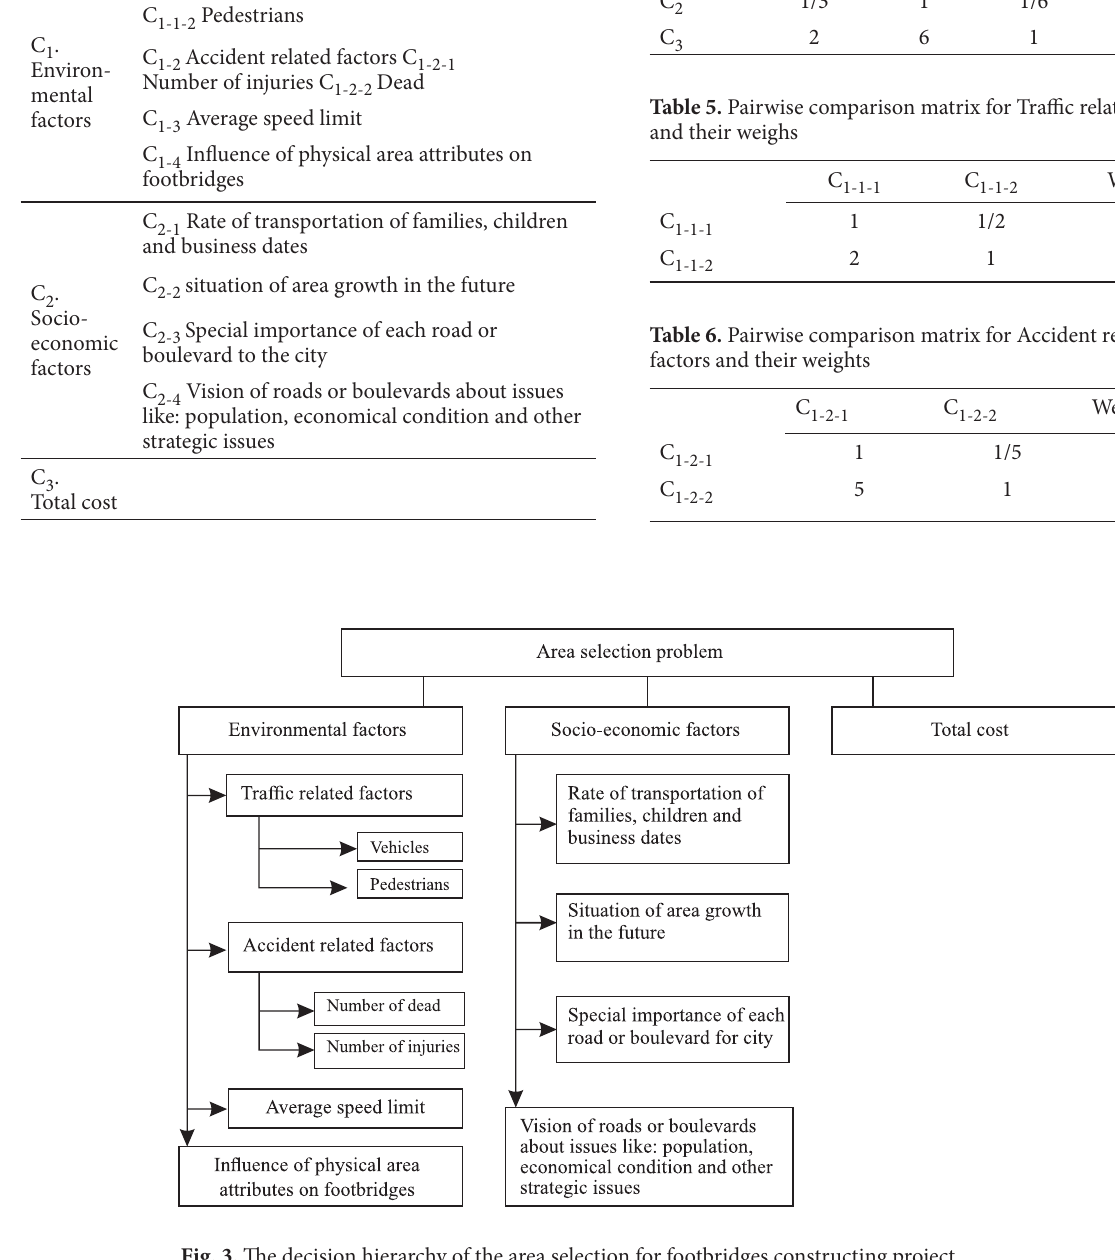
Fig. 3. The decision hierarchy of the area selection for footbridges constructing project